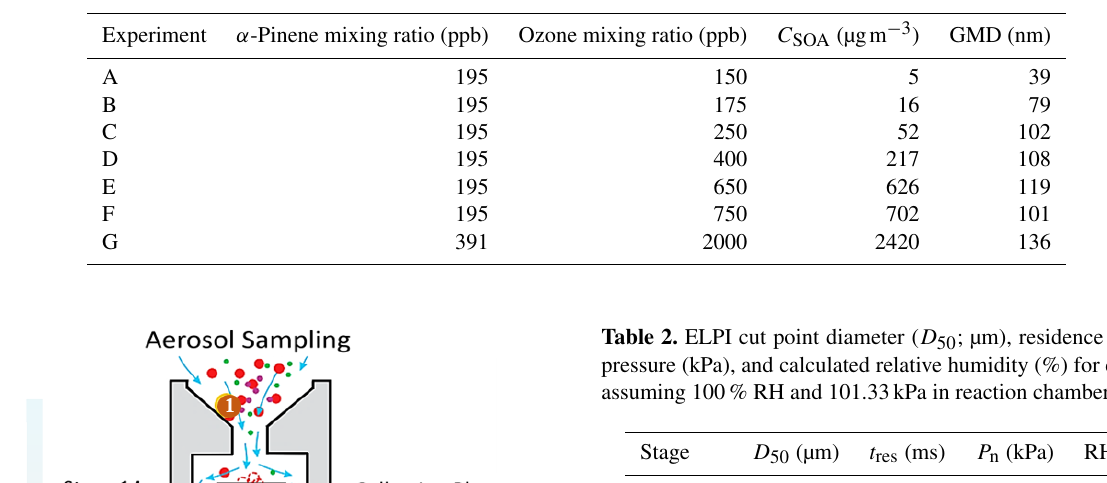
Table 1. Mixing ratios used for each α -pinene-derived SOA experiment. Both SOA mass loading ( C SOA ) and number geometric mean diameter (GMD; from SMPS instrument) were observed immediately prior to initiation of humidification.